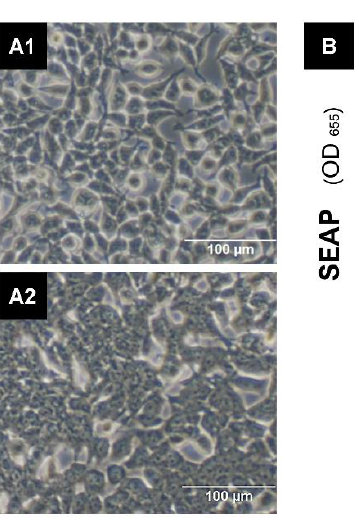
Figure 3. ( A ) Brightfield microscopy image of HEK-Blue TM cells at a 20x magnification; ( A1 ) trans- fected with hTLR2 (HEK-Blue TM hTLR2) and ( A2 ) without hTLR2 (HEK-Blue TM Null1). ( B ) SEAP concentrations measured by QUANTI-Blue TM assay in the supernatant of unstimulated, stimulated, neutralized, and immunomodulated HEK-Blue TM cell cultures; statistical differences regarding to: # p < 0.0001 HEK-Blue TM Null1 & Unstimulated HEK-Blue TM hTLR2, *** p < 0.005 LTF & Anti-hTLR2-